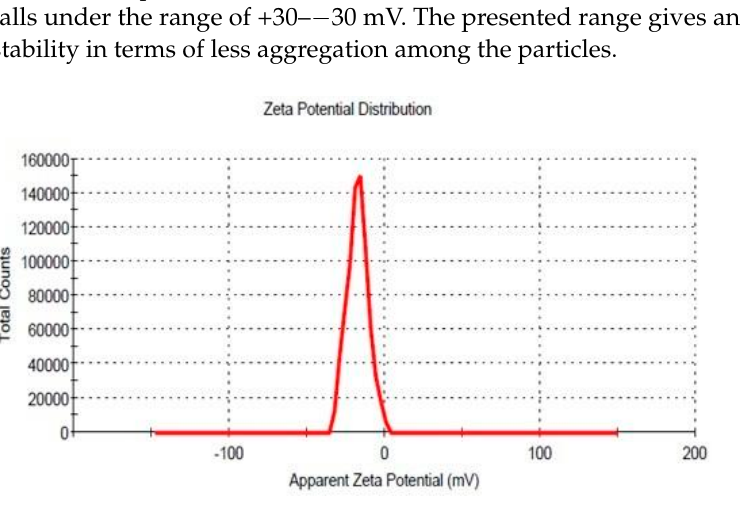
Figure 2. Zeta potential graph of optimized formulation.